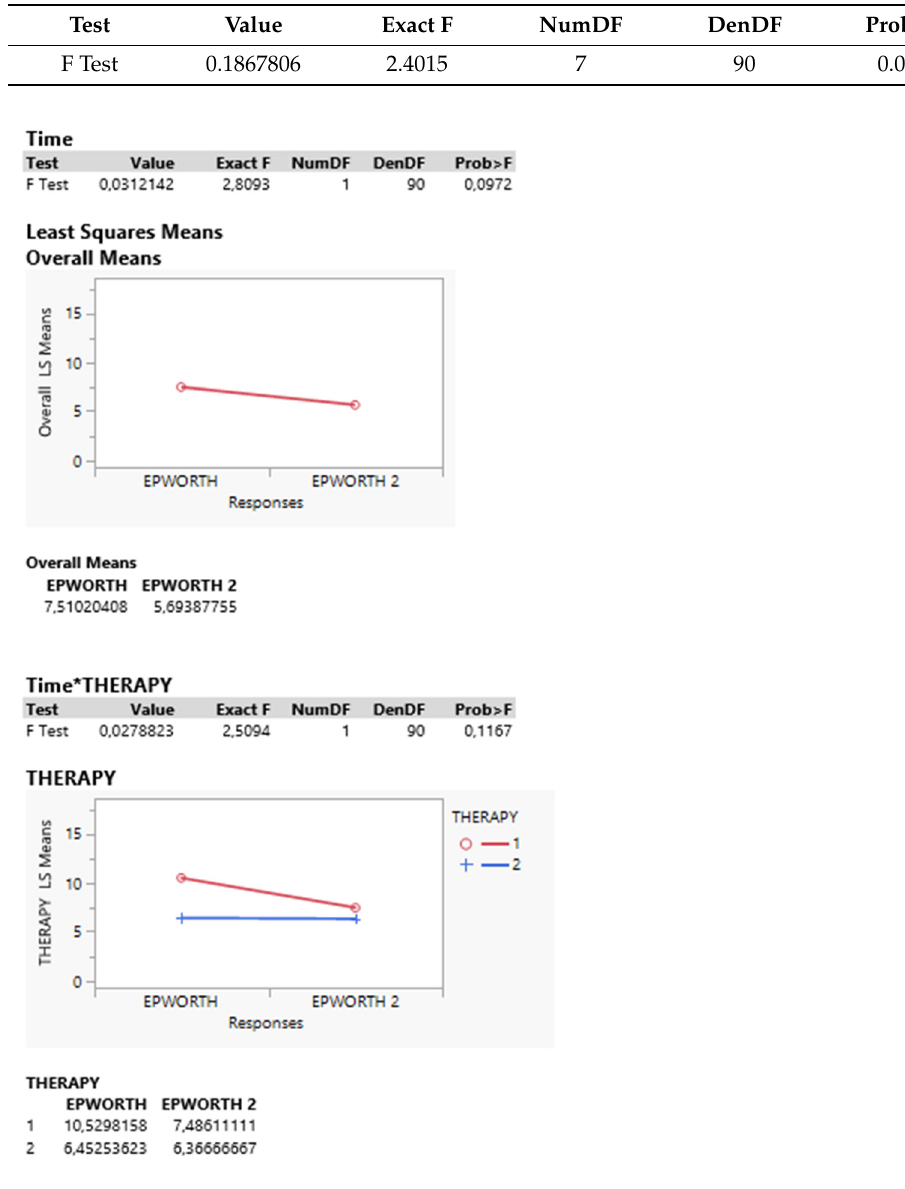
Figure 1. Neither interaction between time and therapy reveals a significant effect ( p = 0.117). Nevertheless, the overall time interaction between responses did not produce significant effect ( p = 0.092), although a decrease in Epworth response was observed after treatment. On the contrary, the time*disease interaction signals a significant effect ( p = 0.004) vividly demonstrated in the following interaction plot. It appears that the main cause of disease influence derives from the decreasing SD and mainly PD physical conditions at post treatment time or Epworth response, Figure